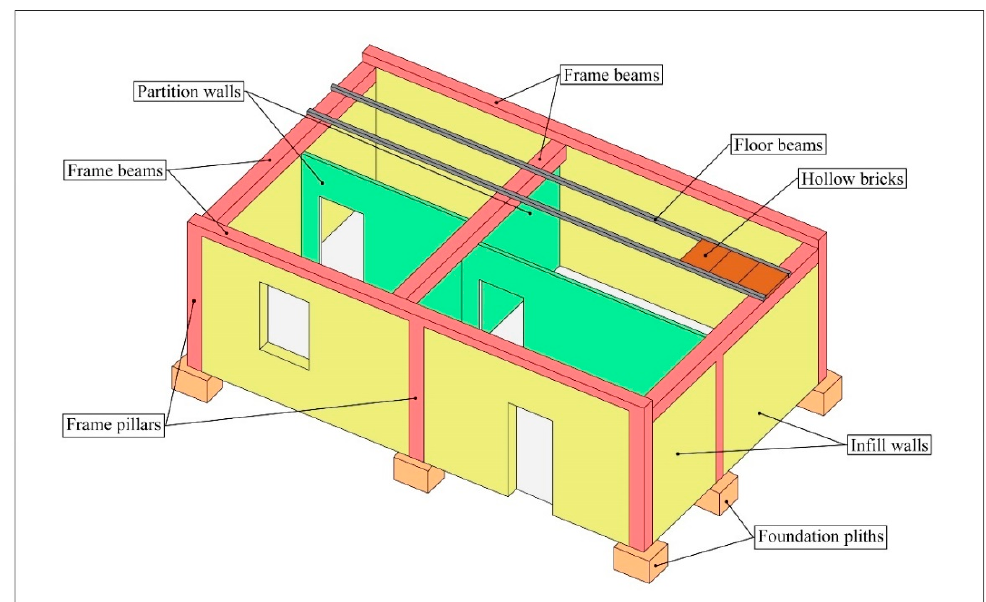
Figure 6. Rigid frame building scheme (drawing by G.B.).